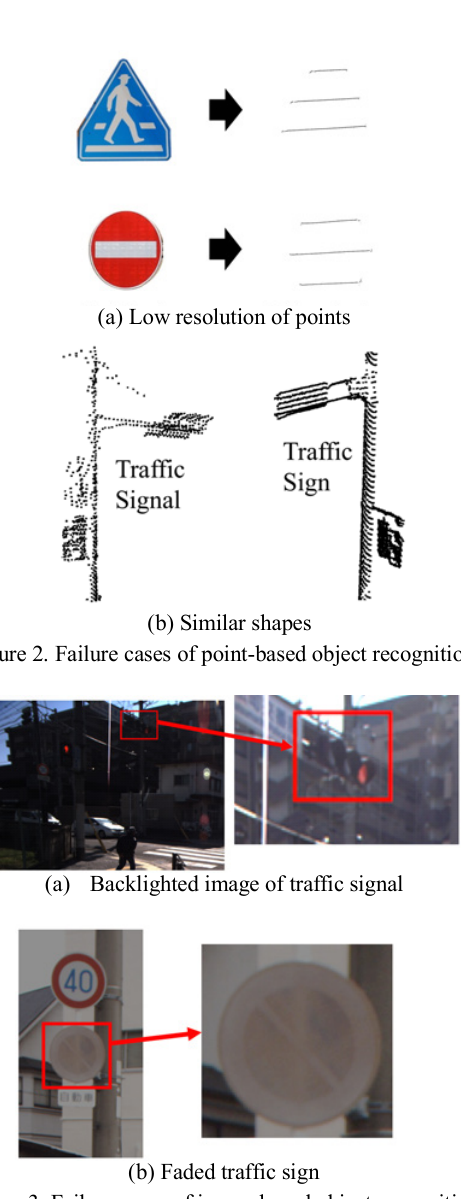
Figure 3. Failure cases of image-based object